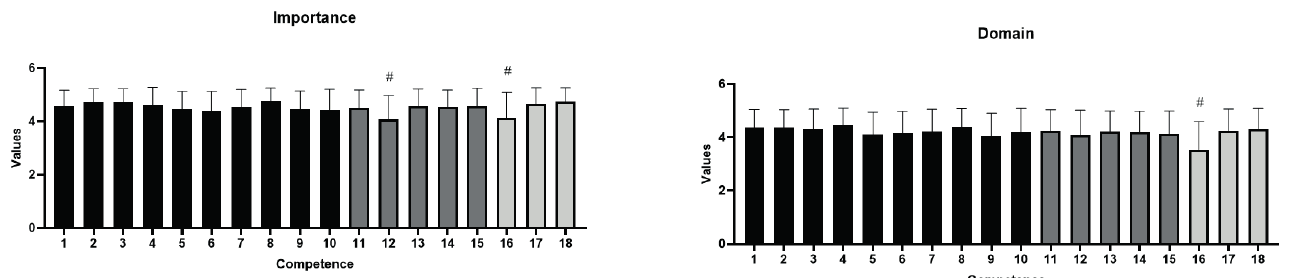
Figure 4. Comparison between the attributed importance and perceived domain about the competence of racket sports coaches. Legend: # significantly lower in Friedman test (p<0.001).